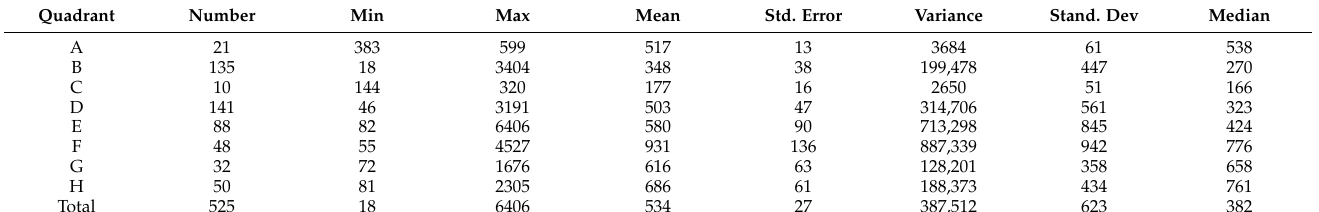
Table 3. Summary statistics of fort size by perimeter (m) organized by quadrant.